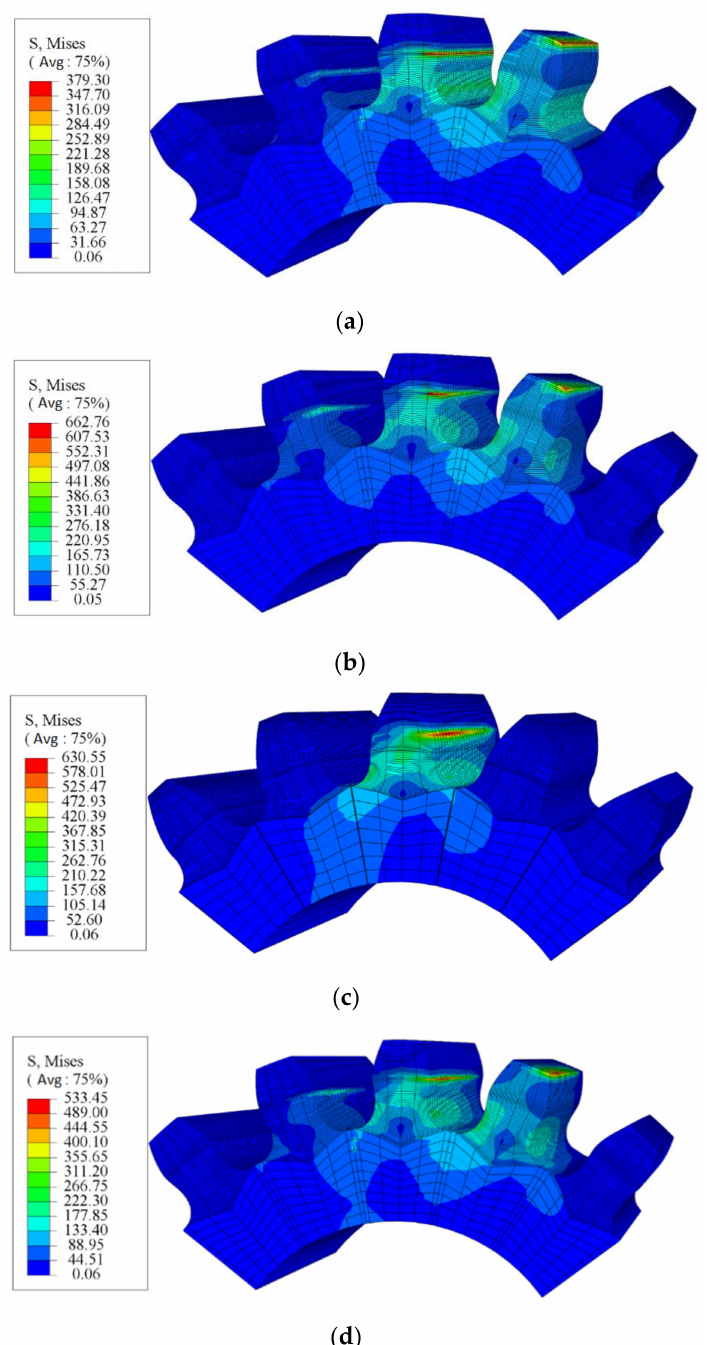
Figure 18. Comparison of tooth surface load distribution between novel gears and involute gears at the pitch circle position, ∆ γ = 3 (cid:48) . ( a ) Unmodified involute gear; ( b ) Unmodified novel gear; ( c ) Modified involute gear; ( d ) Modified novel